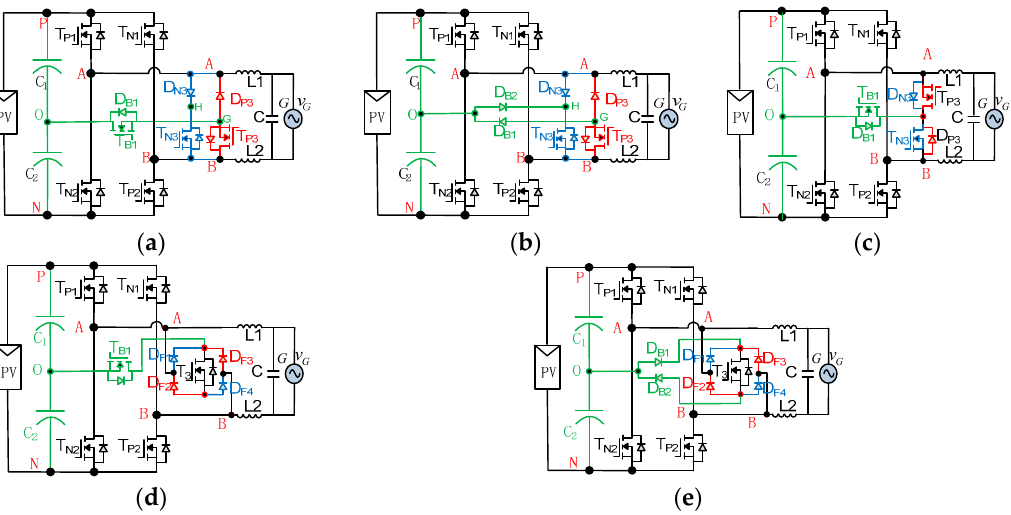
Figure 8. Indirect Connection NPC topologies from M = 2, N = 2. ( a ) R1S1-1 [50]; ( b ) R1S1-2 [18,50,51];